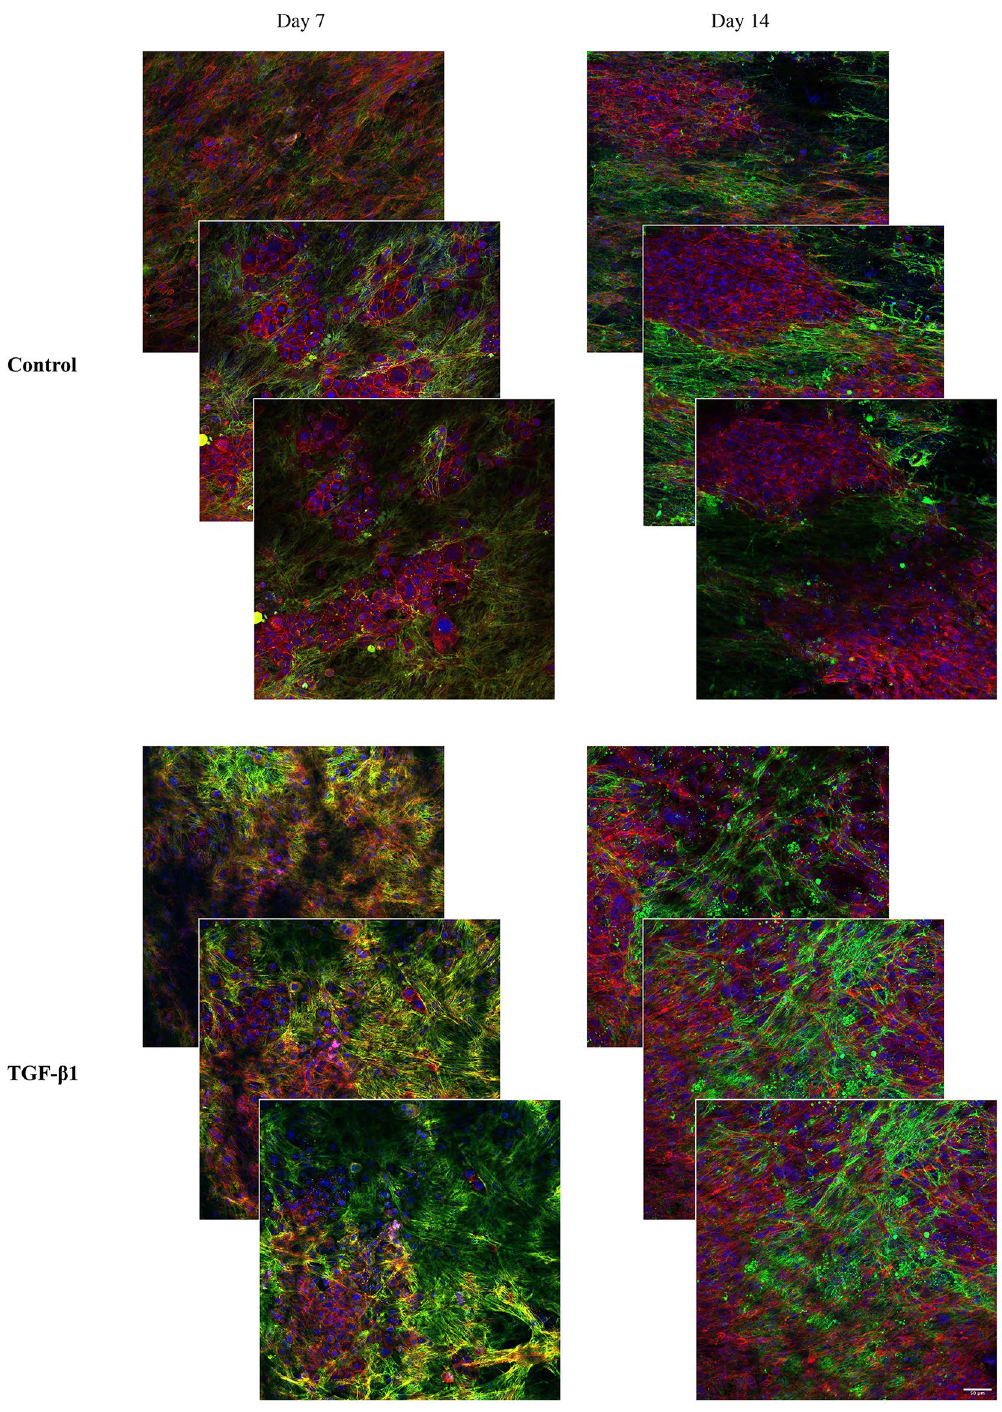
Figure 8. Focus stacking images obtained by confocal microscopy of fibronectin deposition and localization in 3D co-cultures of JIMT-1/HDFs. Three confocal plane images were obtained with approximately 10 µm distance from each other in the 3D cultures. JIMT-1/HDF 3D co-cultures were incubated in the absence (control) or presence of 5 ng/ml TGF-β1for 7 and 14 days. Cultures were fixed in 3.7% formaldehyde and labelled to visualize actin (red), fibronectin (green), and cell nuclei (blue). All images are representative of 3 independent experiments. Scale bar in 50